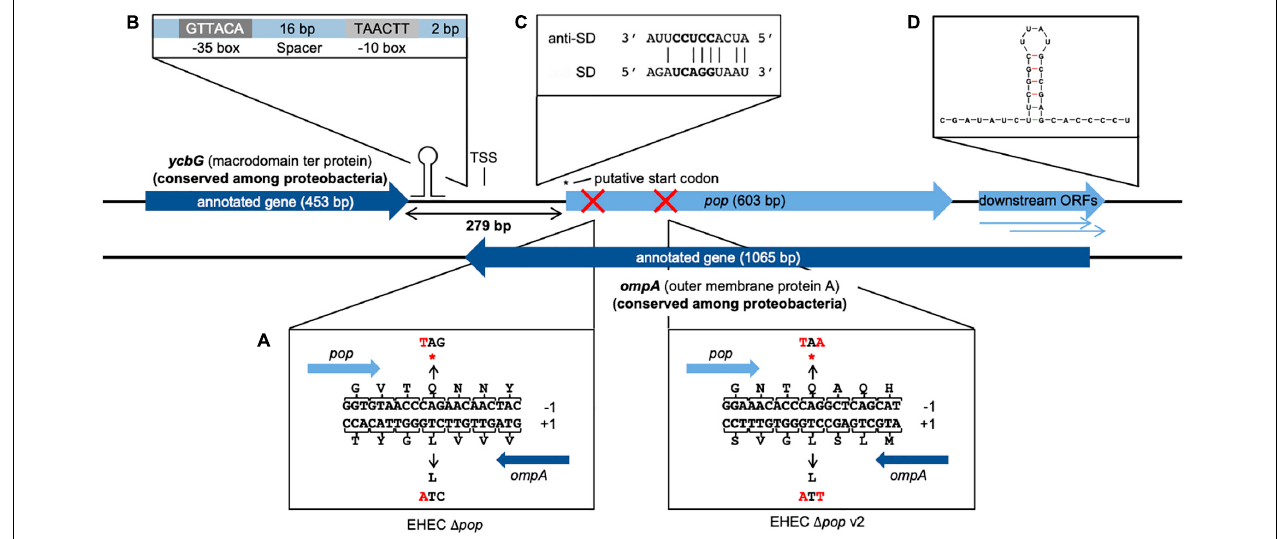
FIGURE 1 | Genomic organization and operon structure of pop . pop (603 bp) is located downstream of the annotated gene ycbG and completely embedded antisense in the sequence of ompA . Downstream of pop exist two smaller overlapping open reading frames, which overlap ompA almost completely and are referred to as downstream ORFs. A transcription start site (TSS) was experimentally identified in the intergenic region of pop and ycbG . The full genomic sequence of pop is given in Supplementary Figure S1 . (A) Design of translationally arrested mutants of pop . The overlapping ORF pop is located in reading frame − 1 with respect to ompA . Genomic mutants for phenotypic characterization contained a single base substitution C → T at genome position 1236083 for EHEC (cid:49) pop or C → T and G → A at genome positions 1236302 and 1236304 for EHEC (cid:49) pop v2 (indicated with red crosses), leading to stop codons ( * ) in pop and synonymous changes in ompA . (B) Promoter sequence. The sequences of the − 10 box and − 35 box as well as the length of the spacer between the conserved boxes and the distance to the TSS are shown. (C) Alignment of Shine-Dalgarno (SD) sequence of pop and anti-Shine-Dalgarno (anti-SD) sequence. The predicted SD sequence ( (cid:49) G ◦ = − 3.6 kcal/mol) upstream of the putative start codon is aligned to the consensus of the anti-SD sequence of the 16S rRNA in the 30S ribosomal subunit (Ma et al., 2002). The core of the ribosome binding site is displayed in bold letters. (D) Secondary structure of the first 40 bp of the predicted terminator. The folding was conducted with Mfold and the structure has a final energy of (cid:49) G = − 8.6